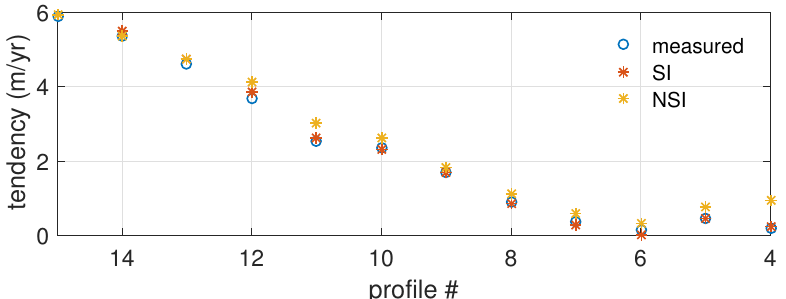
Figure 9. Beach progradation rates computed using in-situ measurements, SI images and NSI